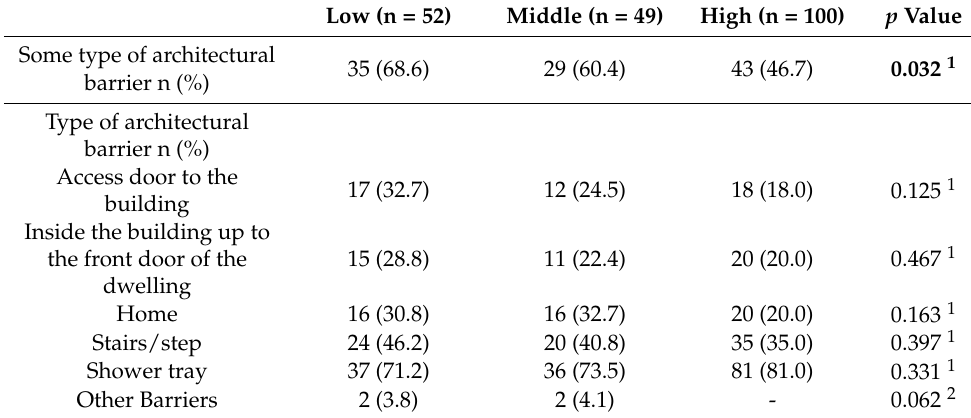
Table 4. Architectural barriers in the home.